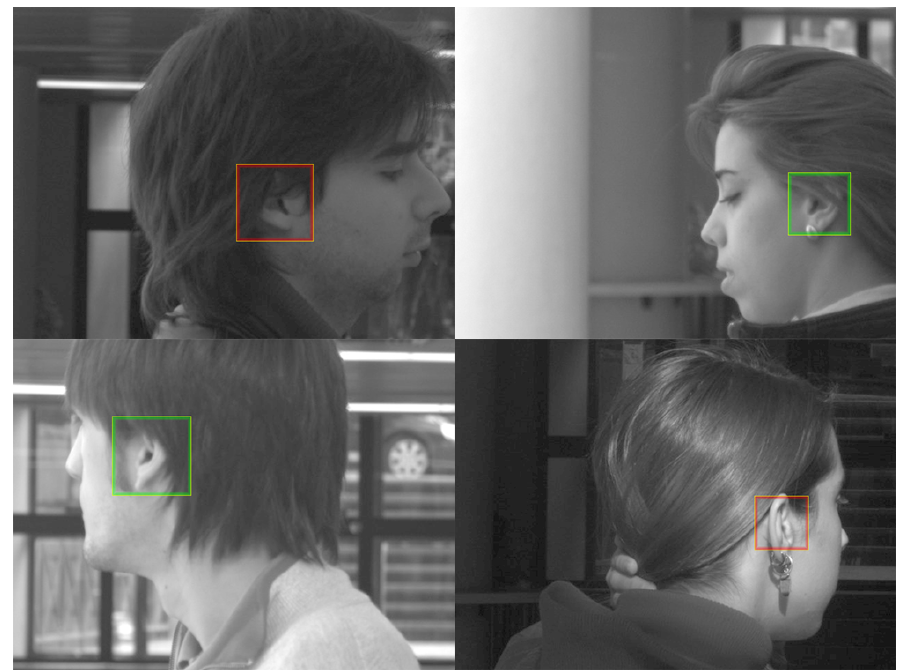
Figure 13. Sample detections on particularly difficult images from the UBEAR dataset, including extreme head orientations and occlusion. Table 8. Detection performance of our 3-CNN system vs. Haar on the different data folds of the UBEAR